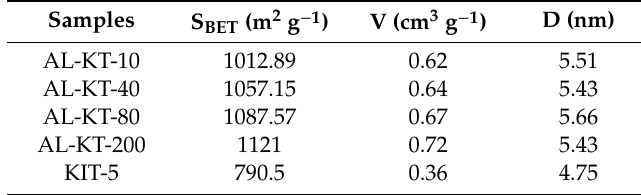
Table 1. The pore structural properties of supports.